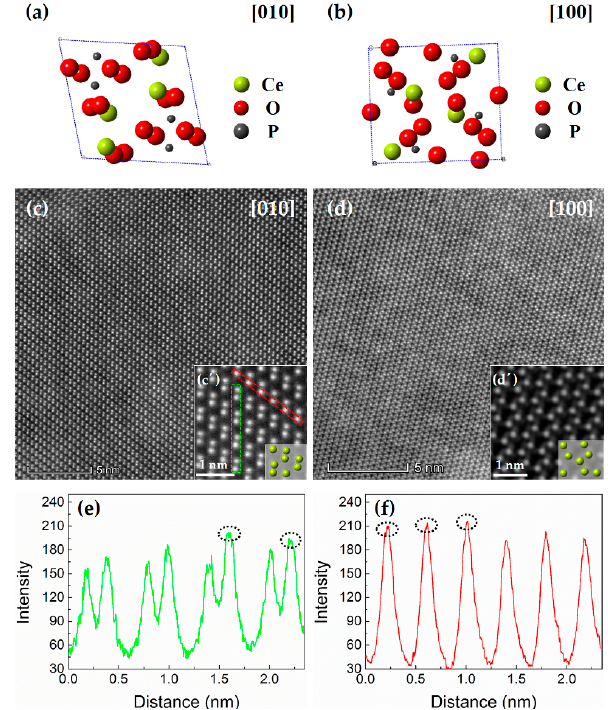
Figure 5. ( a , b ) Atomic models of CePO 4 along [010] and [100] crystallographic orientations. ( c , d ) The scanning TEM (STEM) and high-angle annular dark field (HAADF) images of the monazite foils viewed along the [010] and [100] direction, respectively. The insets (Figure 5 c´ , d´ ) are enlarged HAADF images of this monazite and the models of atomic arrangements of Ce (for CePO 4 ) along the [010] and [100] direction, respectively. The kelly green spheres correspond to Ce atoms. ( e , f ) The intensity profiles of atomic clomuns from the green rectangular box and red rectangular box, which are shown in ( c´ ).